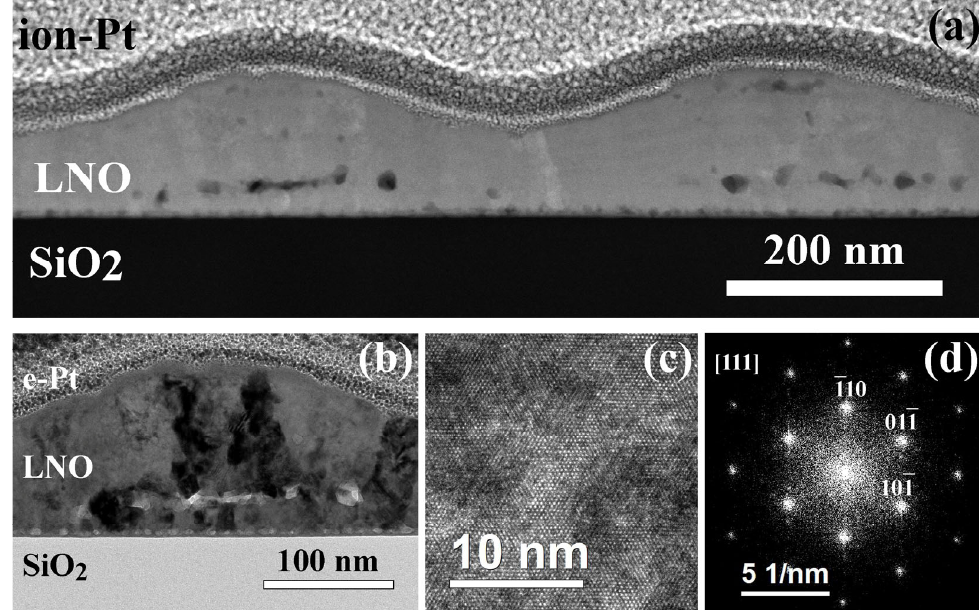
Figure 9. Structure of an LNO ‐ cryst ‐ 20 min sample: HAADF STEM image ( a ), BF TEM image ( b ), HRTEM image ( c ), and the corresponding Fourier diffraction pattern ( d ).